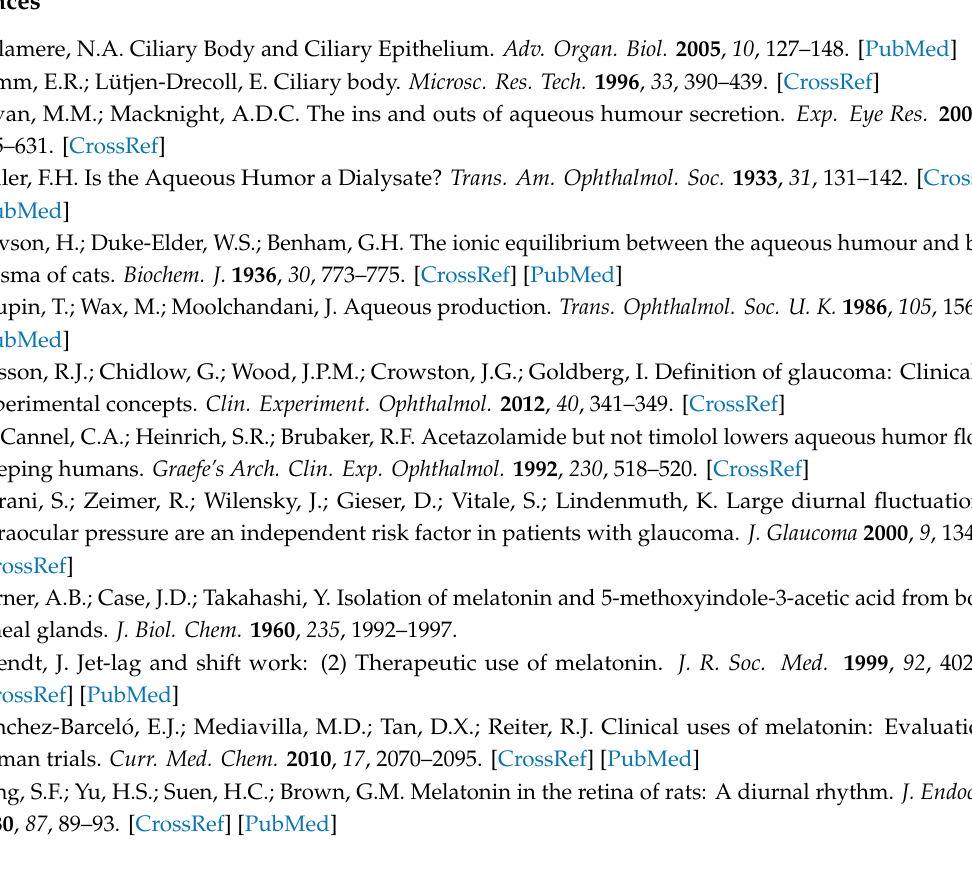
Figure A3. The specificity of antibodies against D 3 , MT 1 , and MT 2 receptors. Confocal microscopy images of the HEK-293T cells untransfected (bottom) or transfected with cDNAs coding for D 3 , MT 1 , or MT 2 receptors (0.5 µ g). The cells were treated with primary antibodies against either D 3 , MT 1 , or MT 2 receptors (as indicated), and subsequently treated with a Cy3 secondary antibody (red). Images were taken near the bottom of the cell and, therefore, reflect the labeling in the membrane in contact with the slide. Cell nuclei were stained with Hoechst (blue channel). Scale bar: 20 µ m.